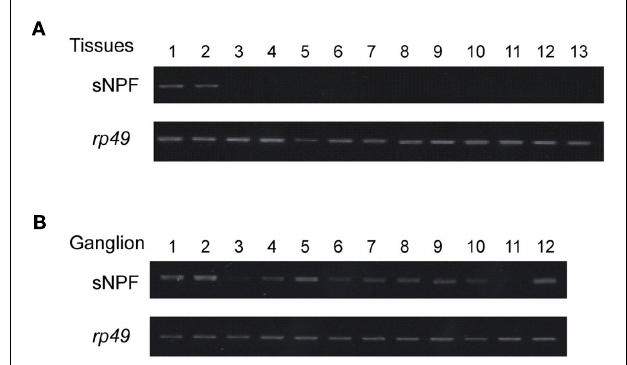
FIGURE 2 | Reverse transcription-polymerase chain reaction-based tissue expression profile of the sNPF precursor. (A) Tissues were isolated from 2-day-old fifth instar larvae: brain (lane 1), central nervous system (CNS) (lane 2), prothoracic glands (lane 3), silk gland (lane 4), foregut (lane 5), midgut (lane 6), hindgut (lane 7), Malpighian tubules (lane 8), fat body (lane 9), muscle (lane 10), hemocytes (lane 11), testis (lane 12), and ovary (lane 13). PCR control consisted of rp49 amplification. (B) RT-PCR of the sNPF precursor in each ganglion from a fifth instar B. mori larvae. Brain (lane 1), subesophageal ganglion (lane 2), thoracic ganglia (lanes 3–6), abdominal ganglia (lanes 7–12).